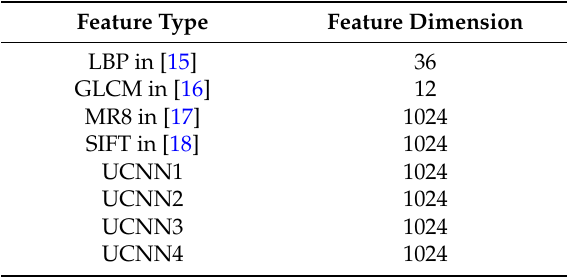
Table 1. Feature set for representing high-resolution remote sensing